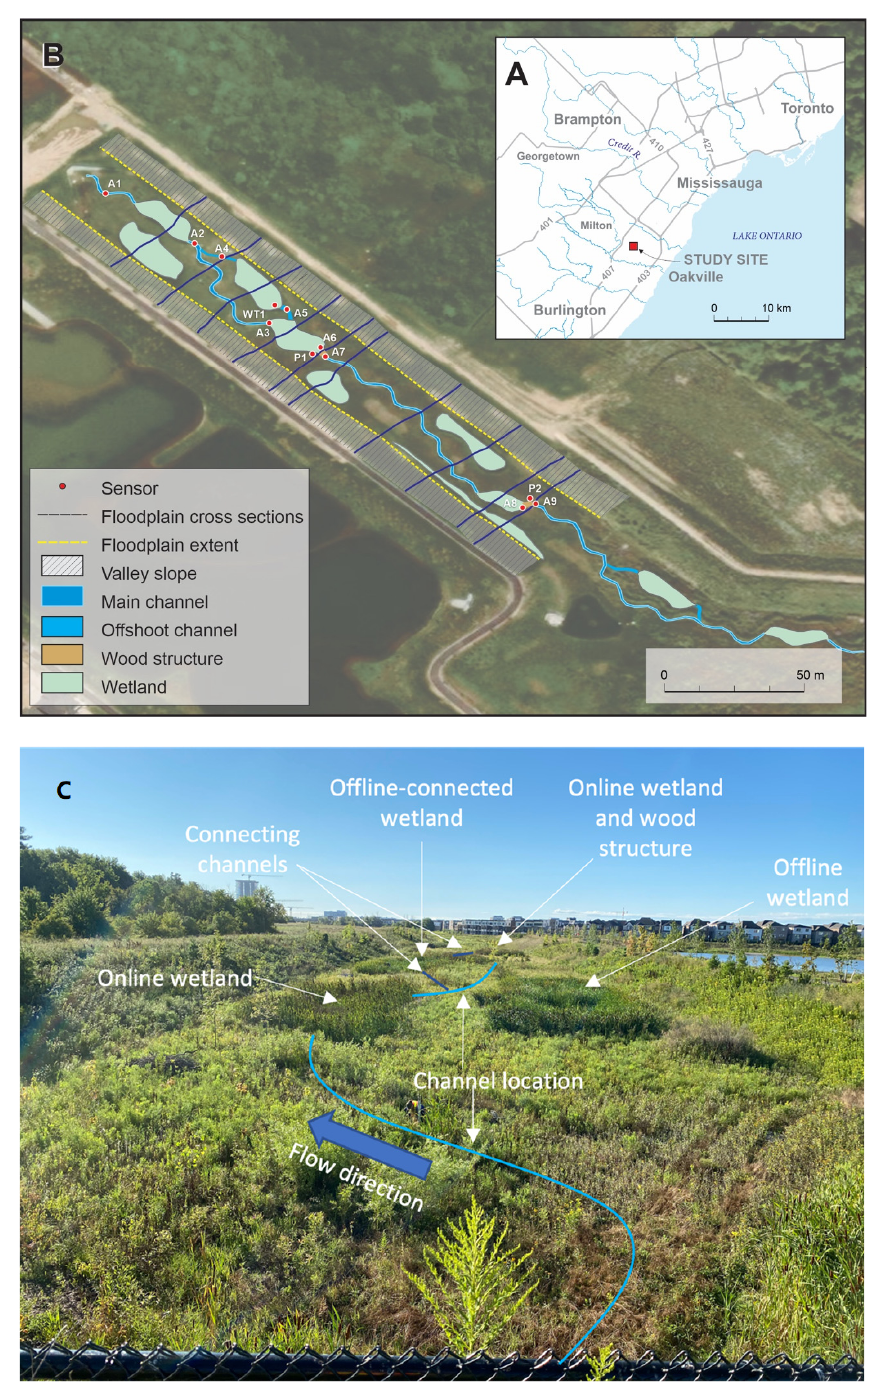
Figure 1. ( A ) Study area within the East Morrison Creek basin in southern Ontario, Canada. ( B ) Site planform view underlain by an UAV photo. Within the river corridor there is a main channel that contains online, offline, and offline-connected wetlands and wood structures. Sensor locations, floodplain lateral extent, and valley slope area are also shown. Flow is from northwest to southeast. Inset maps highlight locations with dense sensor locations. Map projection is NAD 1983 UTM Zone 17N. ( C ) Oblique photo from the upstream section looking downstream over the site. Wetland and channel locations are identified on the photo. Photo taken 10 June